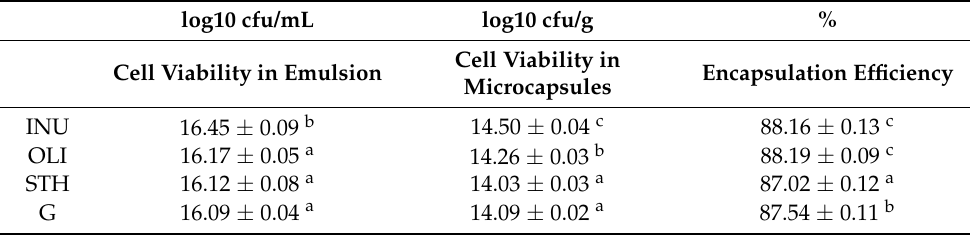
Table 2. Cell viability before and after encapsulation. Encapsulation efficiency %. log10 cfu/mL log10 cfu/g % Cell Viability in Cell Viability in Emulsion